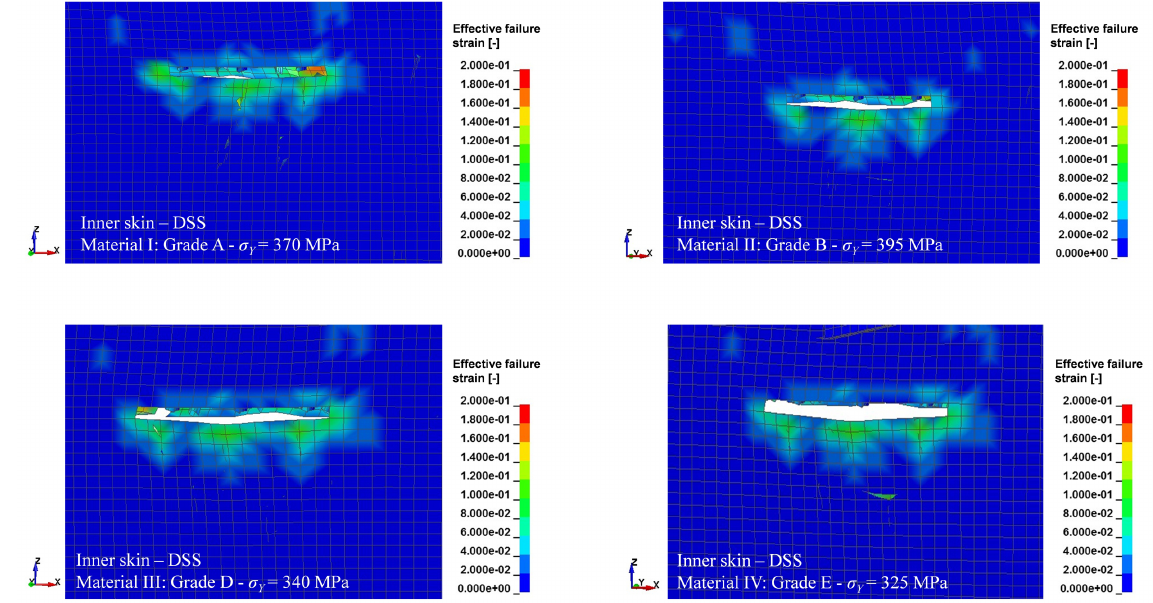
Figure 9: Conditions of the inner skin after later impact. Contour expansion indicated that less failure strain and tearing length were experi- enced by the Material II – Grade B with σ Y = 395